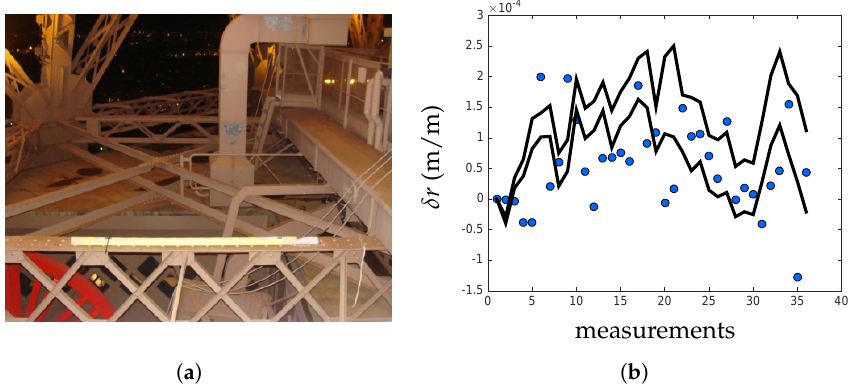
Figure 7. Comparison between linear deformation measured by DInSAR ant the linear deformation measured by the optical strands installed on the Eiffel Tower by OSMOS. ( a ) Optical strand on the Eiffel Tower c (cid:13) OSMOS ( b ) • Lineic DInSAR deformation estimated for the Eiffel Tower — Minimal and Maximal lineic deformation measured by optical